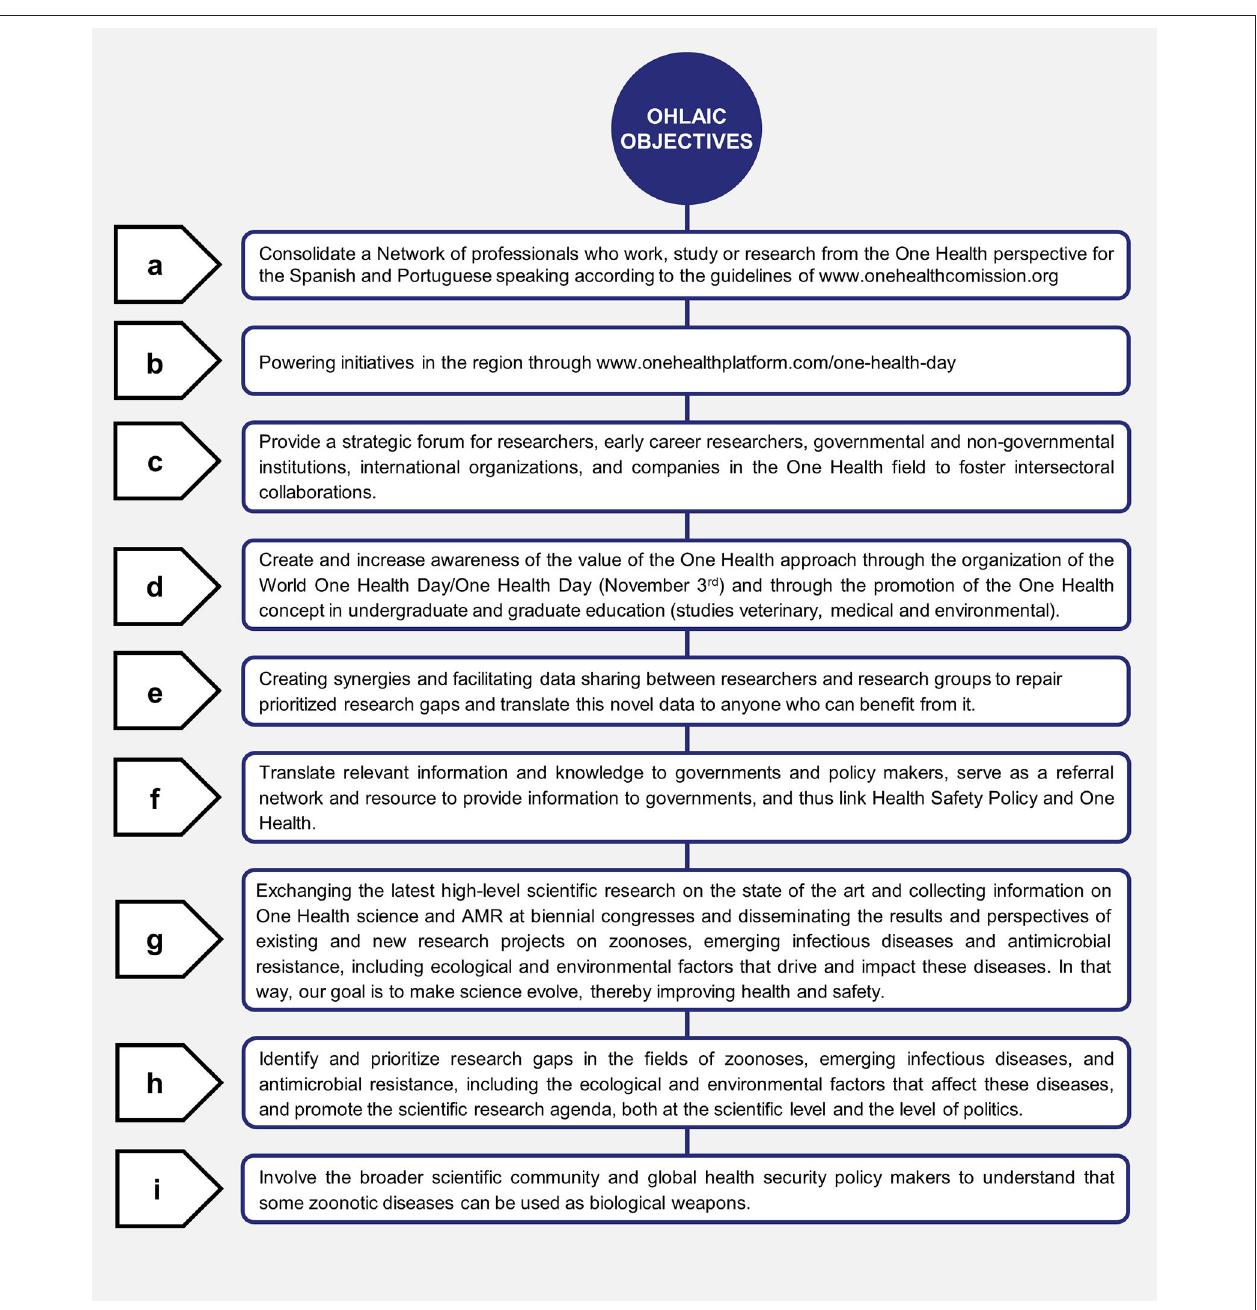
FIGURE 4 | The objectives and goals of One Health Latin America, Iberia, and Caribbean Network.